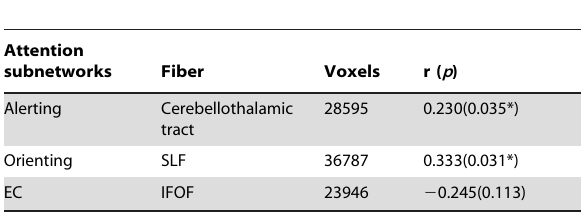
Table 4. Correlations between fiber and attention performance after probabilistic